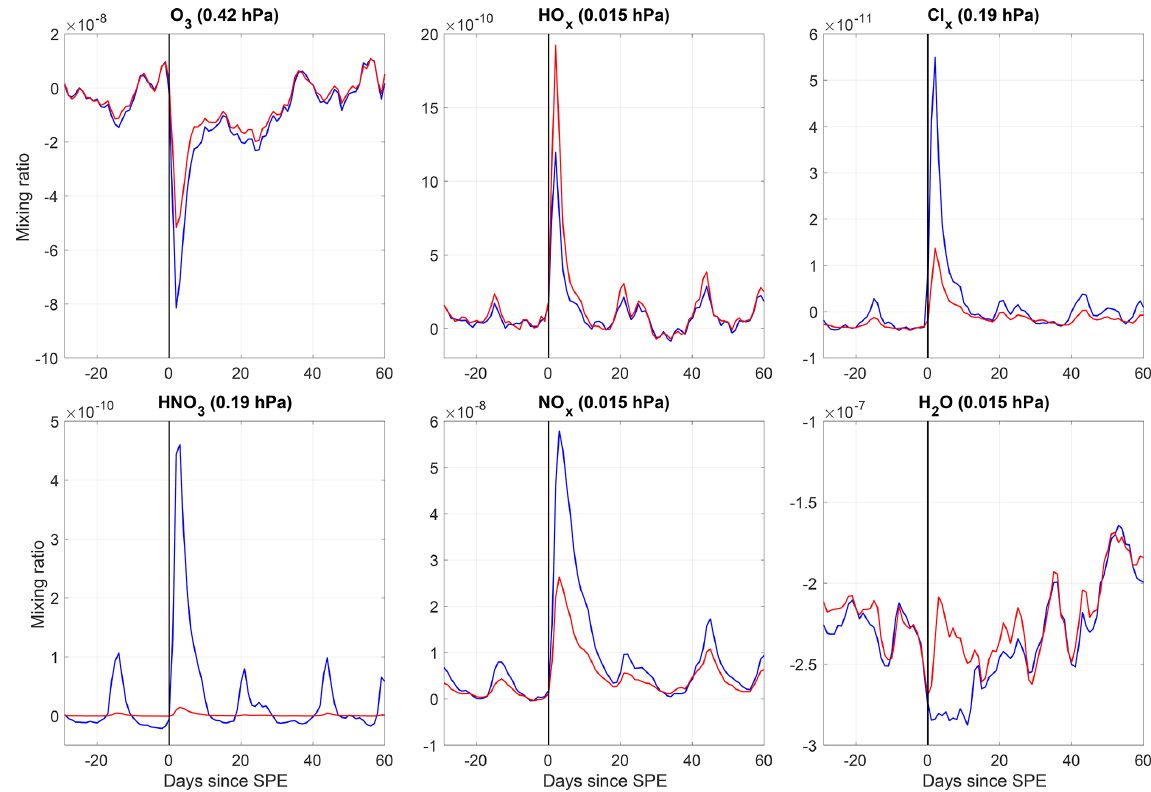
Figure 8. Composite mean (cid:100) WD (blue) and (cid:100) REF (red) for the northern polar cap (area-weighted, latitude > 60 ◦ N) at selected pressure bands (three pressure levels, pressure of the center of the band shown in panel title). The x axis shows the number of days before and after the event (day 0, solid black